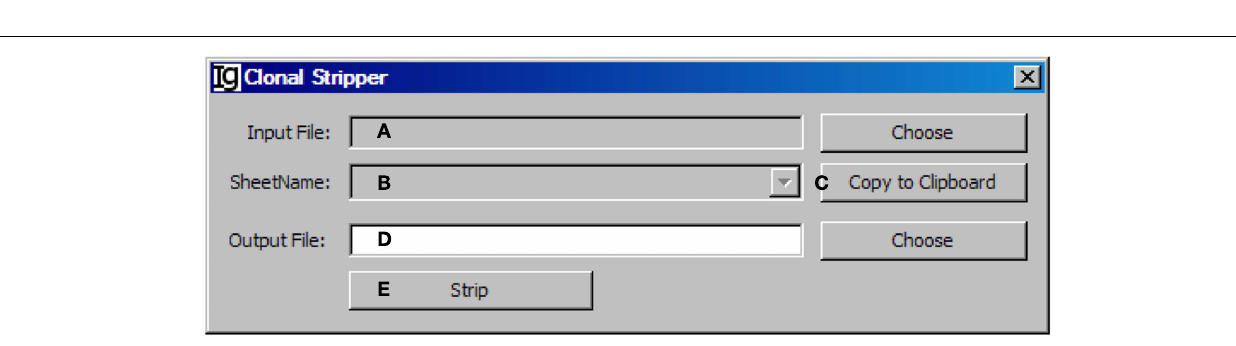
FIGURE 11 |The clonal stripper . Diagram shows the interface of the Clonal Stripper. (A) Button to choose the input footprint analysis result file, which can be CSV file generated by the footprint analyzer or Excel file generated by the Keyword Group Picker. (B) Combo box for selecting the sheet for analysis, if an Excel file is selected in (A) . (C) Button to copy the name of selected sheet to the clipboard. (D) Button to choose the output file. (E) Button to start the stripping process.